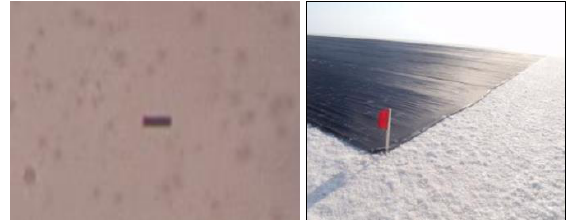
Figure 7. Tarpaulins as seen in Göktürk-2 images (left). Same tarpaulins as seen from the ground (right).